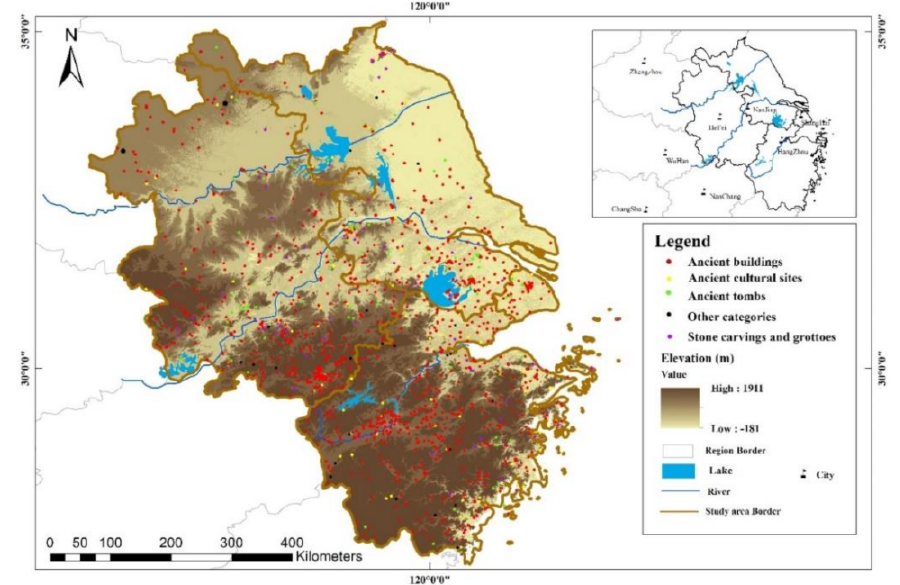
Figure 2. Spatial distribution of Archaeological Sites in the study area of five historical dynasties.